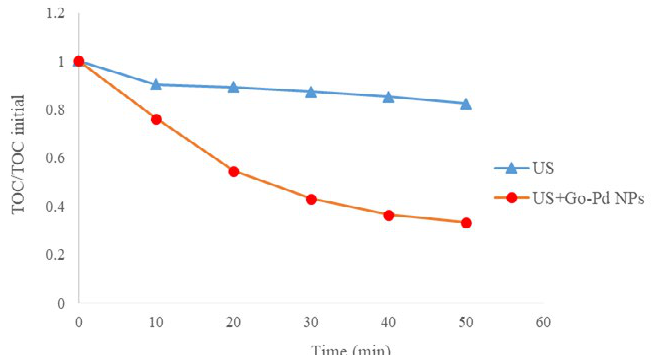
Fig. 12. Change in TOC as a function of time for different degradation processes in presence of Go-Pd NPs